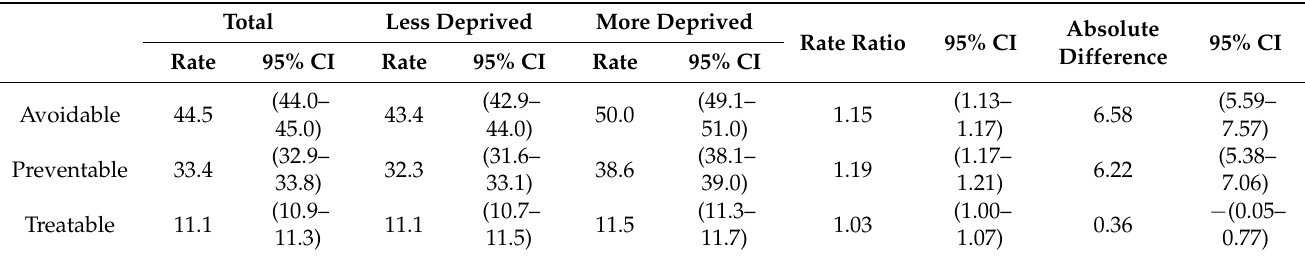
Table 1. Age-standardized cancer-related avoidable, preventable, and treatable mortality rates per 100,000 population by area deprivation